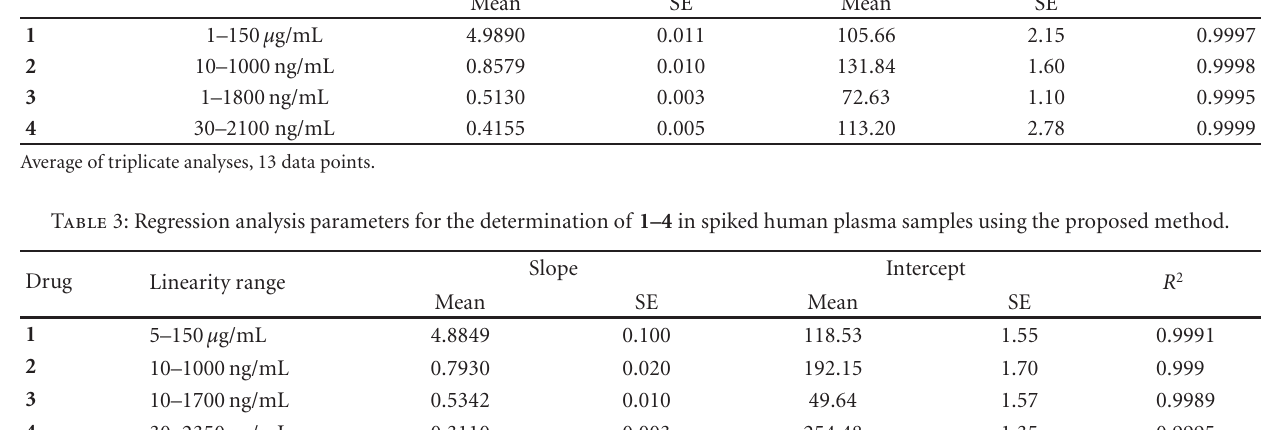
Average of triplicate analyses, 13 data points.